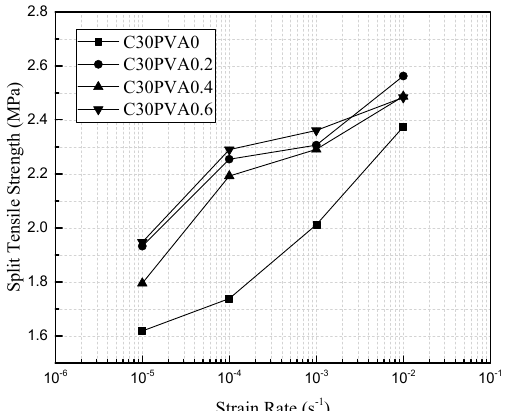
Figure 6. Split tensile strength of FRC (C30).